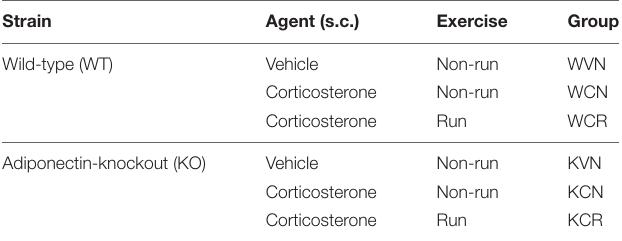
TABLE 1 | Animal grouping for the in vivo experiments. Strain Agent (s.c.) Exercise